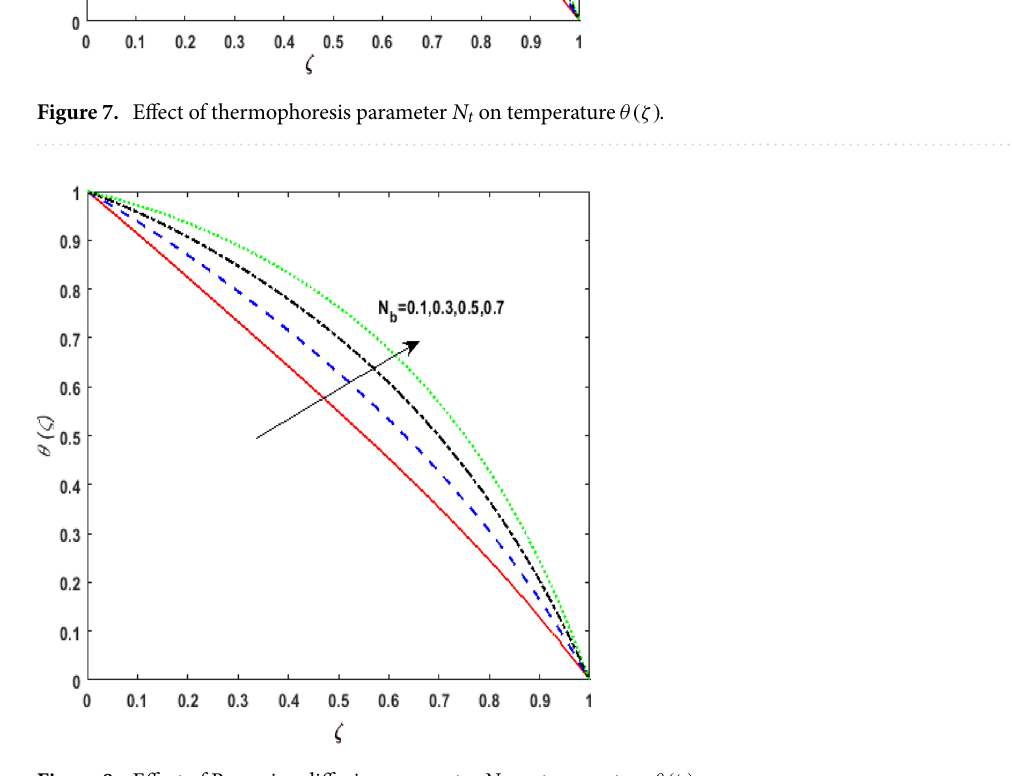
Figure 8. Effect of Brownian diffusion parameter N b on temperature θ(ζ)